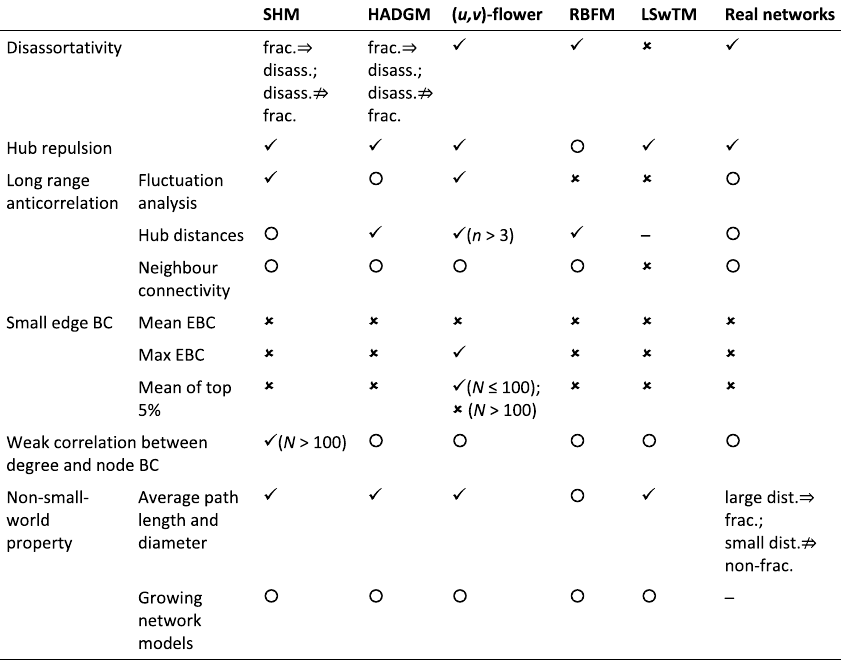
Table 8 The relation of network models and real networks to the examined conjectures concerning fractal characteristics. The check mark ( (cid:31) ) denotes that the model/real networks support the statement (for real networks it means that the distribution of the metric is statistically significantly different in fractal and non‑fractal networks), the cross mark ( × ) means that they contradict it, i.e. they behave in the opposite way, the circle ( (cid:31) ) refers to mixed results and when no clear conclusion can be drawn, moreover, the hyphen (–) denotes when the analysis could not be carried out due to the nature of the model. Finally, N denotes the number of nodes and n denotes the number of